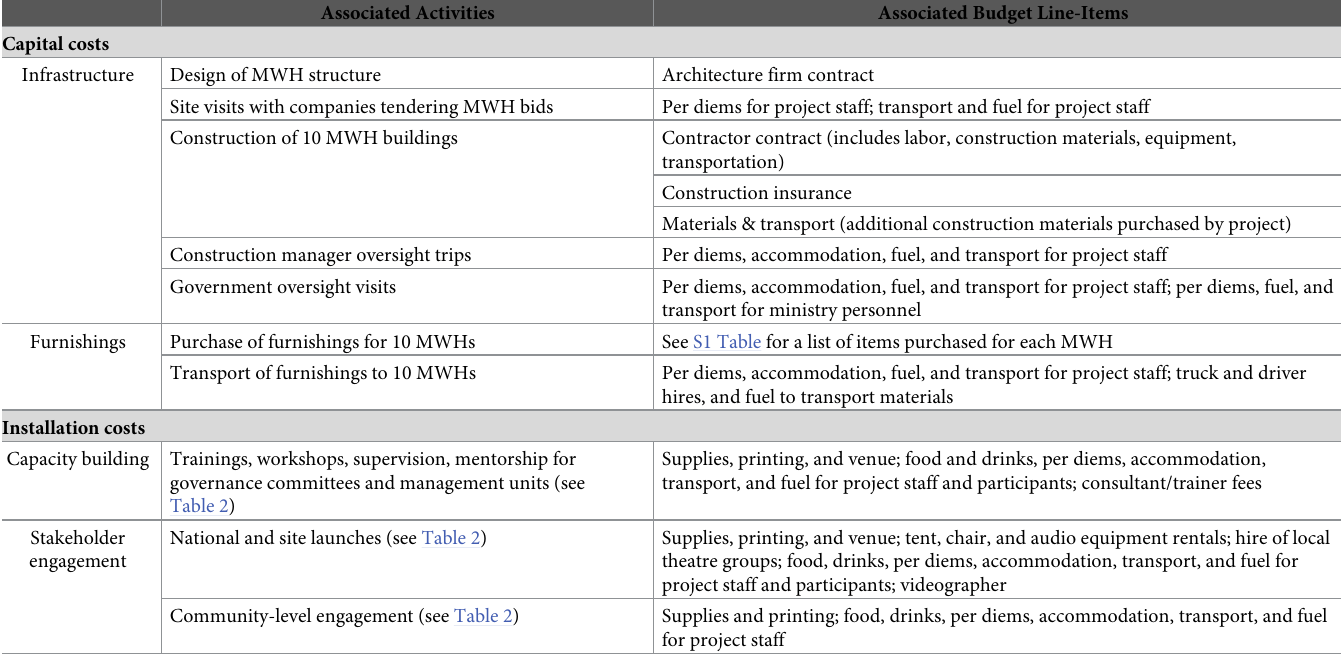
Table 1. Description of the budget line-items associated with each activity and the overarching costing